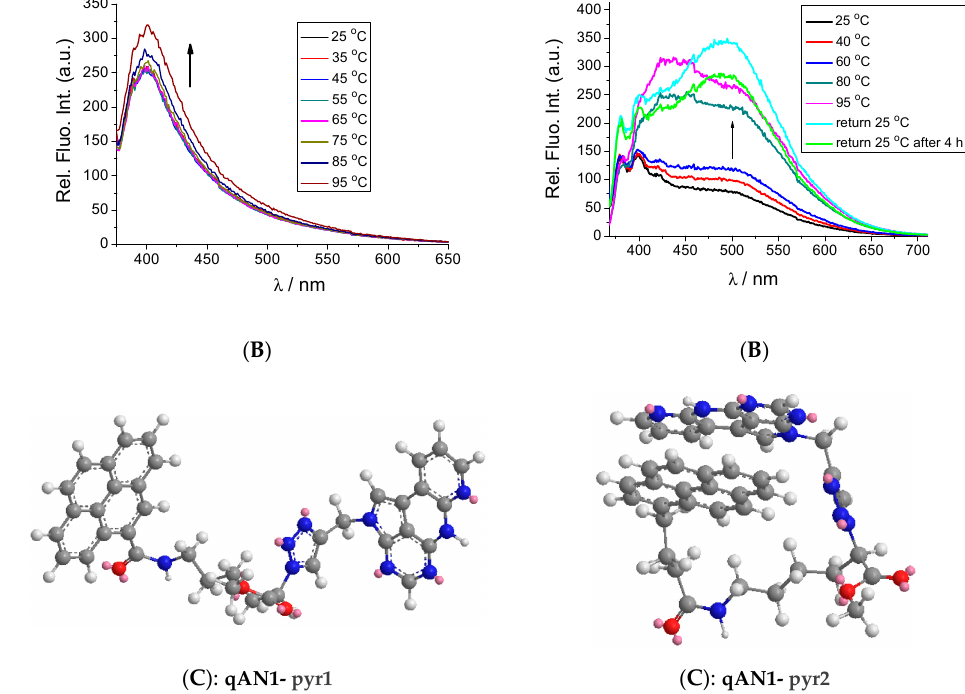
Figure 3. Comparison of qAN1-pyr1 and qAN1-pyr2 fluorescence spectra ( λ exc = 350 nm, c = 8 µM, pH 7.0, I = 0.05 M): ( A ) Concentration dependence of emission; ( B ) temperature dependence of emission. ( C ) Schematic presentation of intramolecular organization of qAN1-pyr1 and qAN1-pyr2 according to UV/Vis and fluorimetric data (supported by preliminary energy-minimization done in vacuum, Suppl. Info, Figure S19).